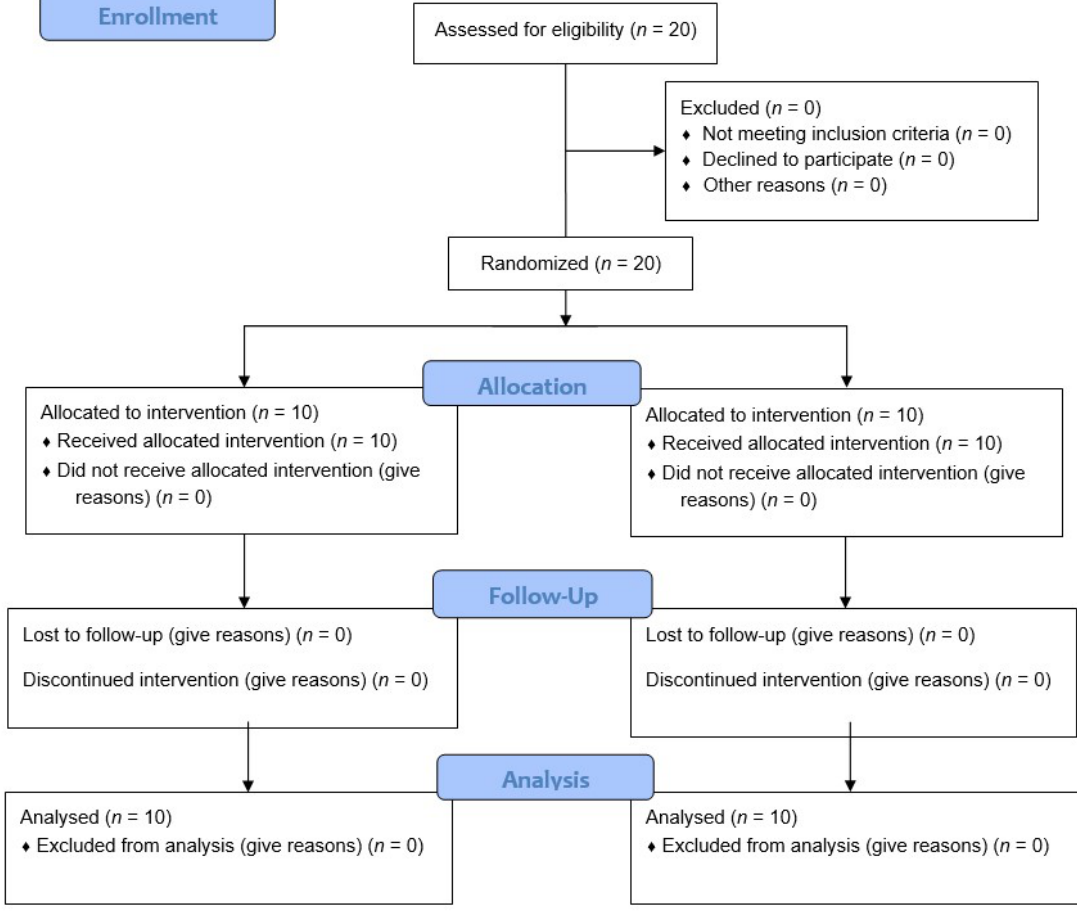
Figure 1. CONSORT Flow Diagram. Table 2. Di ff erences in pain, oedema, and satisfaction between groups according to length of compression